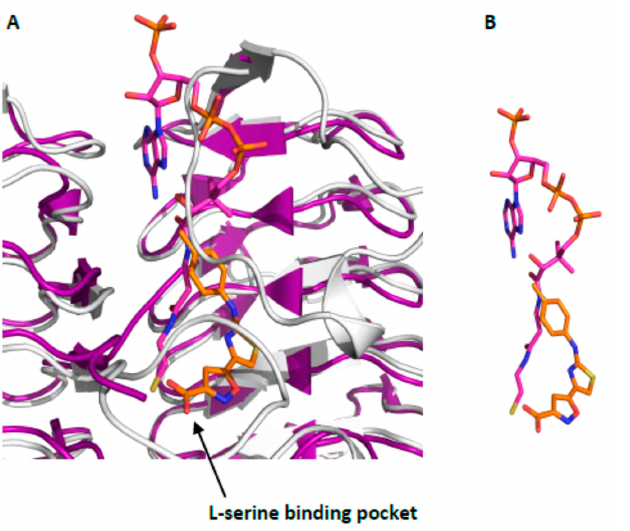
Figure 4. ( A ) docking pose of compound 5 in AcCoA pocket in EcSAT (alignment of structures with pdb code 1T3D and pdb code 1SSM). ( B ) Overlay of the docking pose of compound 5 and AcCoA structure.